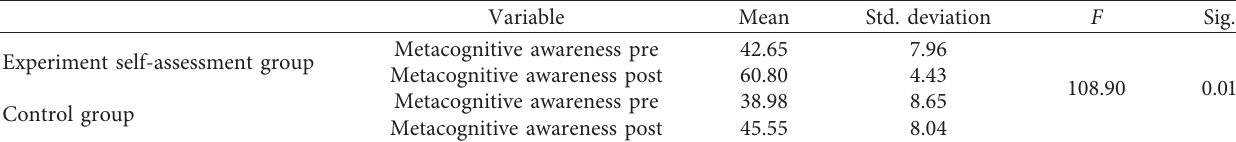
Table 2: Results of covariance for metacognitive knowledge variable in self-assessment group.